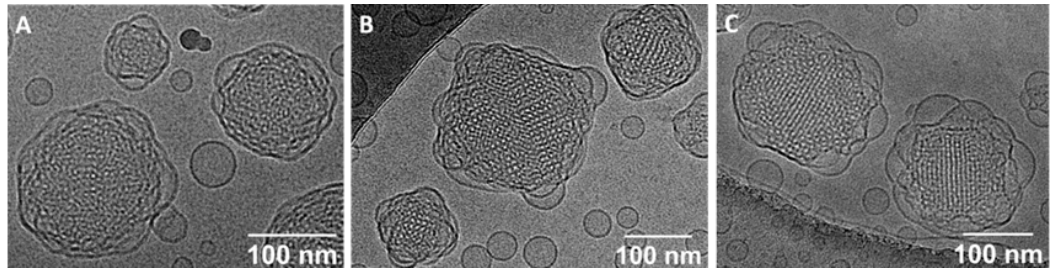
Figure 4. Cryogenic transmission electron microscopy (cryo-TEM) images of ( A ) blank cubosomes, ( B ) cubosomes doped with DOTAGA-OA, ( C ) doxorubicin (DOX) and DOTAGA-OA. 3.3. Radiolabeling of Cubosomes Loaded with DOX and DOTAGA-OA and Carrier Stability